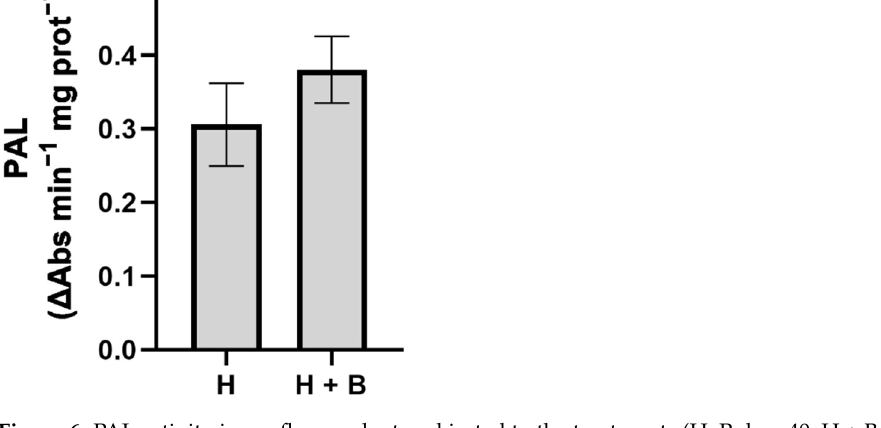
Figure 6. PAL activity in sunflower plants subjected to the treatments (H: Pulsar-40; H + B: Pulsar-40 + Terra-Sorb ® ). Values are expressed as means ± standard error ( n = 9). Table 4. Phenolic compound profile (mg g − 1 DW) in sunflower plants subjected to the treatments. H H + B p -Value 5-CQA (chlorogenic acid)